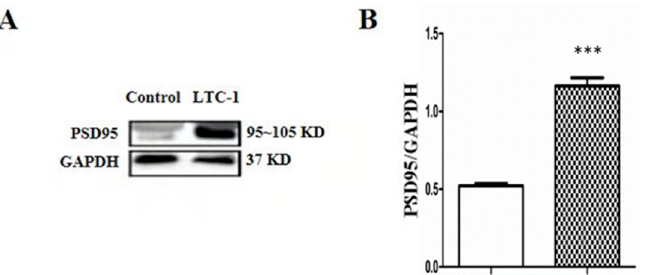
Figure 10. Effect of LTC-1 on the protein expression of PSD95 in hippocampal neurons. ( A ) PSD95 Western blotting results in hippocampal neurons. ( B ) The relative optical density was normalized to GAPDH. One-way ANOVA was used for statistical analysis, followed by Tukey’s multiple compari- son test, *** p < 0.001 vs.